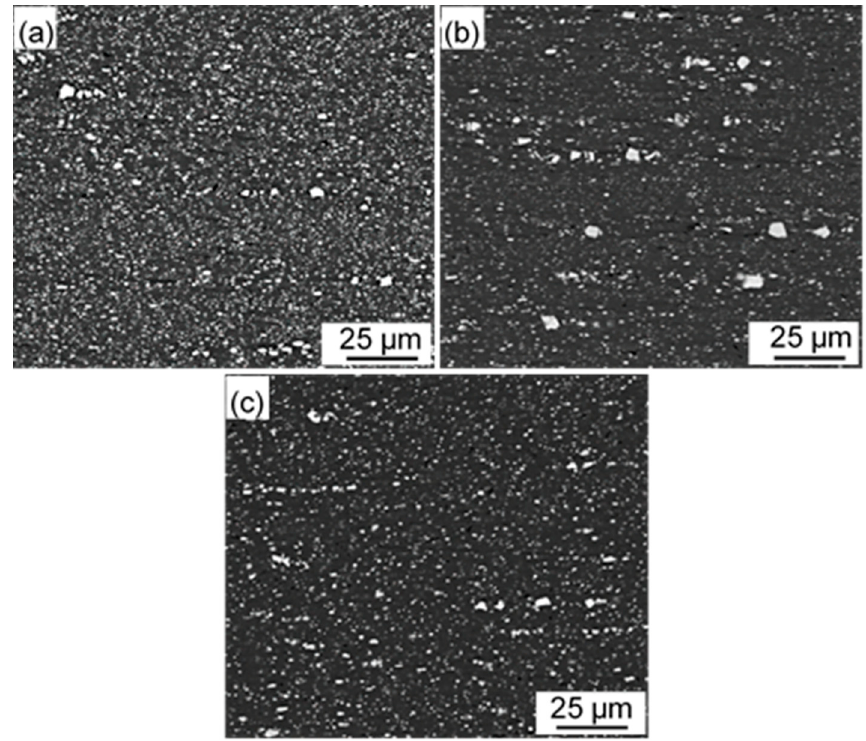
Figure 9. SEM images of 2195 Al ‐ Li alloy sheets after annealing at different temperature. ( a ) Cold ‐ rolled; ( b ) 300 °C; and ( c ) 400 °C.